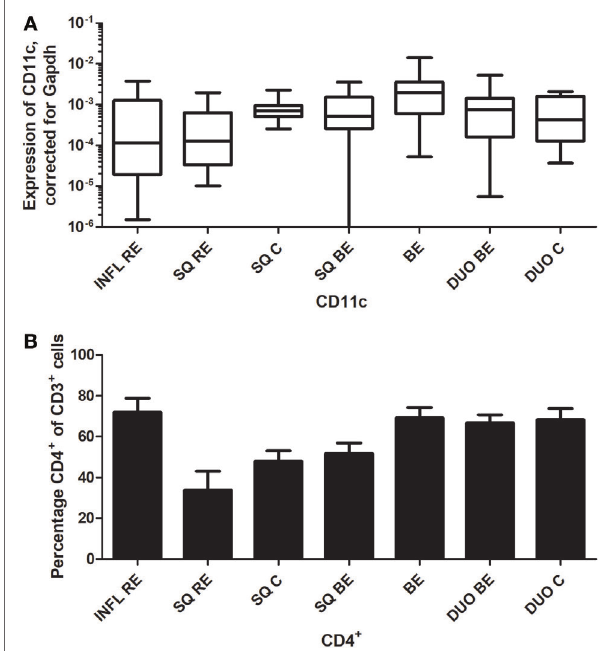
FigUre 7 | Similar CD11c expression in Barrett’s esophagus (BE) and duodenal tissues coincides with higher numbers of CD3 + CD4 + -cells. Panel (a) depicts expression of CD11c by real-time-PCR performed on a total of: biopsies from inflamed tissue in reflux esophagitis (RE) patients (INFL RE, n = 9), non-inflamed squamous esophageal epithelium from RE patients (SQ RE, n = 9), squamous esophageal epithelium from controls (SQ C, n = 12), squamous esophageal epithelium from BE patients (SQ BE, n = 10), BE biopsies (BE, n = 11), duodenal biopsies from BE patients (DUO BE, n = 10), and duodenal biopsies from controls (DUO C, n = 5). CD11c expression was corrected for GAPDH, 2 −Δ CT ± SEM. Panel (B) represent the percentage